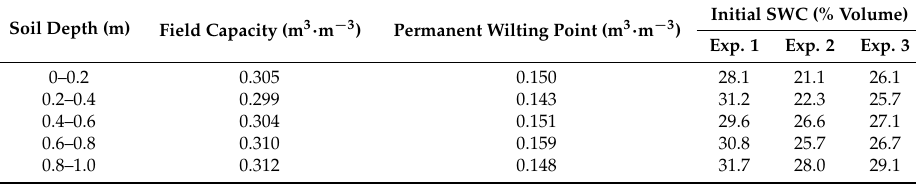
Table 1. Some soil physical properties of the experimental site and initial soil water content (SWC) for the three experiments (Exp.) at different soil profile